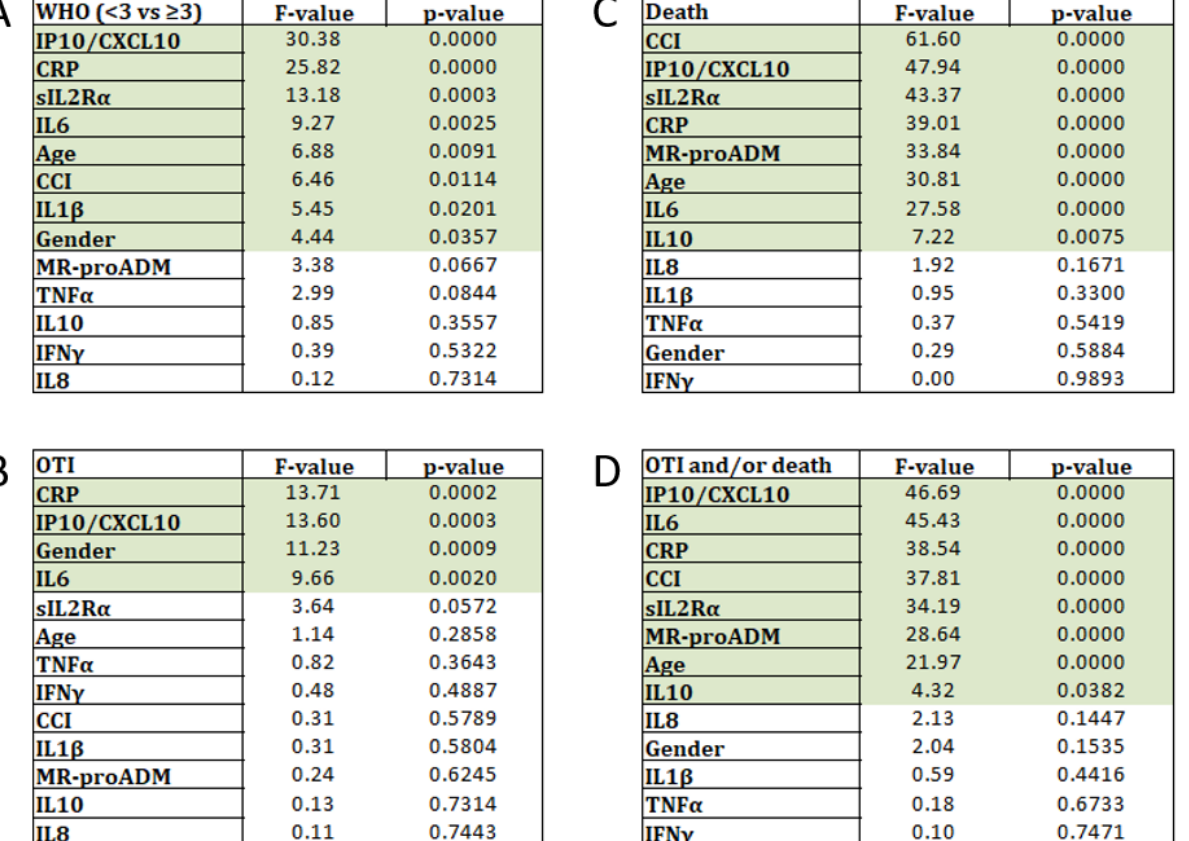
Figure 2. Ranking tests results. ( A ) In panel ( A ) are illustrated the results of the ranking test applied to select the best variables to discriminate between patients with WHO < 3 versus ≥ 3. ( B ) In panel ( B ), are illustrated the results of the ranking test to select the best variable to discriminate between patients who needed or not OTI; ( C ) in panel ( C ), the results to discriminate between patients who deceased or not and finally, ( D ) in panel ( D ), the best variables to discriminate between patients who have generally had a negative outcome or not. Significant markers are shown in shadows of green.